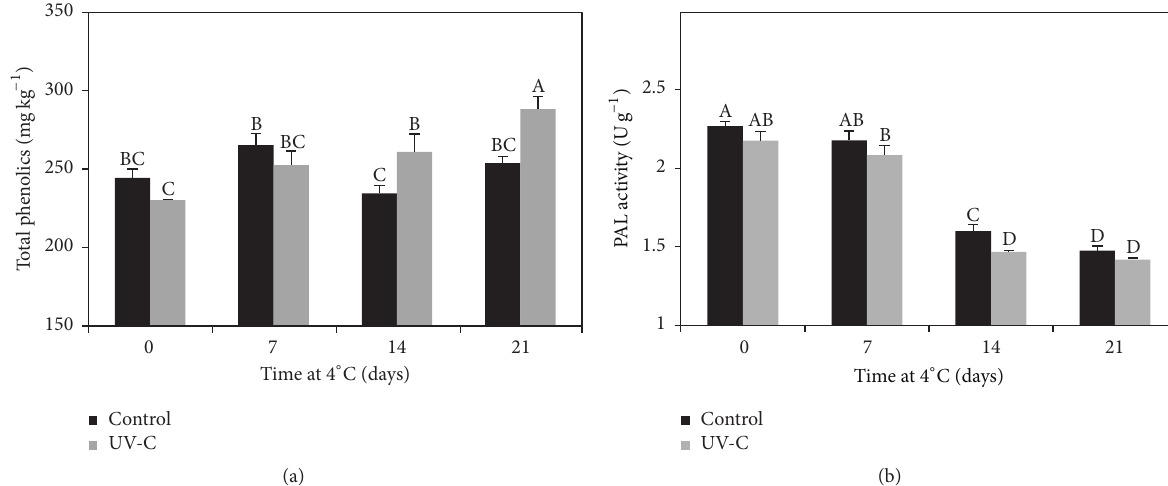
Figure 6: (a) Total phenolics and (b) phenylalanine-ammonia lyase (PAL) activity in control and UV-C treated (12.5kJ m −2 ) carambola slices stored for 0, 7, 14, and 21 d at 4 ∘ C. Bars represent the standard error ( 𝑛 = 3 ). Different letters indicate significant differences on Fisher’s test ( 𝑃 < 0.05 ).